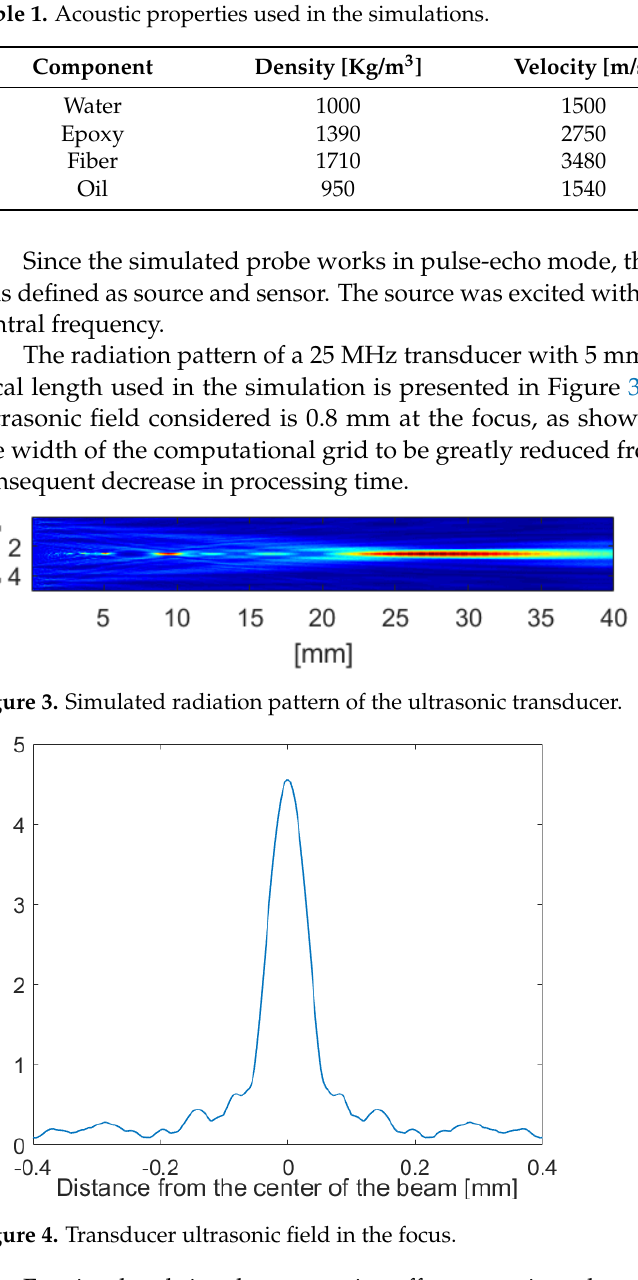
Figure 2. Simulated defective structures: ( a ) total debonding at the ply junction (black line); ( b ) de- lamination inside the ply (black rectangle); ( c ) foreign body representing grease (white disk); ( d ) broken fibers (grey area).